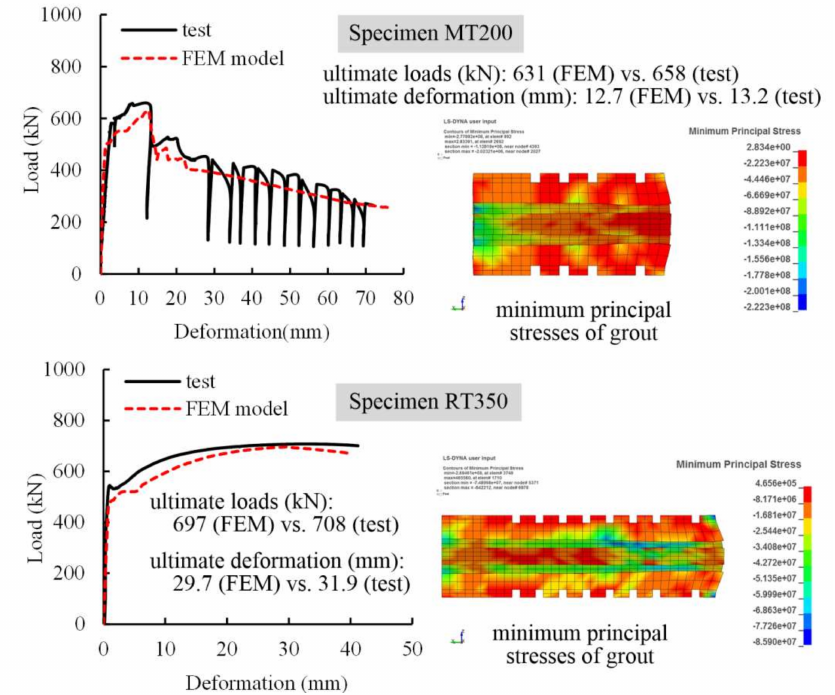
Figure 17. Load-deformation curves of Specimens MT200 and RT350 using FEM models and test